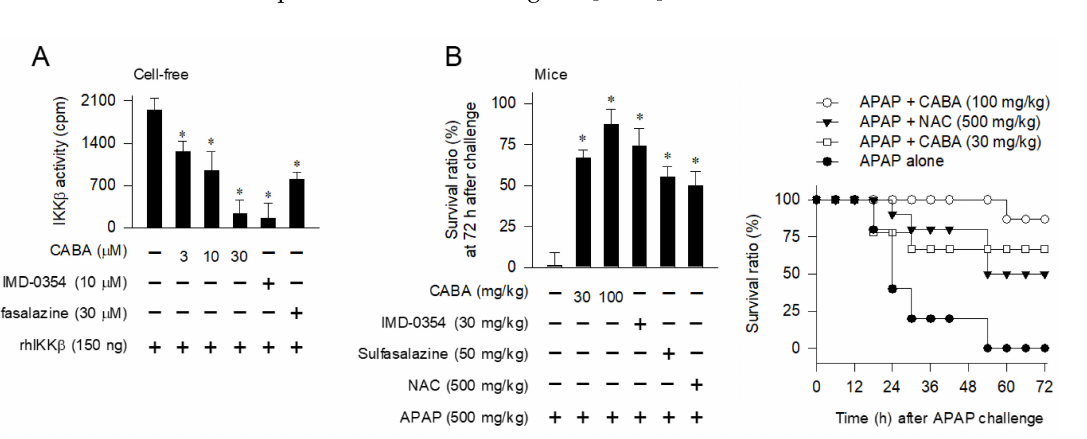
Figure 2. Effects of IKK β inhibitors on IKK β activity and APAP-induced mortality. ( A ) Catalytically active rhIKK β was treated with CABA for 10 min in cell-free reactions. In vitro kinase activity was determined by the incorporation of [ 32 P] onto MBP as exogenous substrate from [ γ - 32 P]-labeled ATP, and represented as count per min (cpm). * p < 0.05 vs. IKK β alone. ( B ) C57BL/6 mice were treated with CABA at 1 h after APAP overdose. Survival ratio was examined until 72 h. Three independent tests were performed with 9 to 11 mice per group. * p < 0.05 vs. APAP